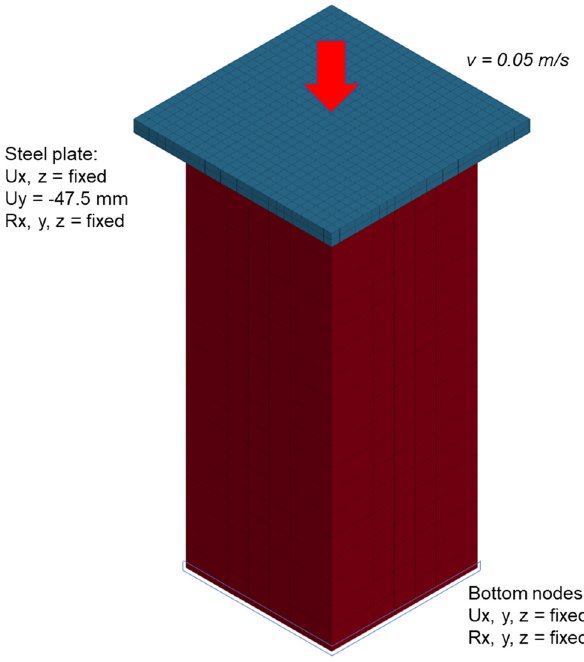
Figure 9: Finite element con fi guration and boundary condition.